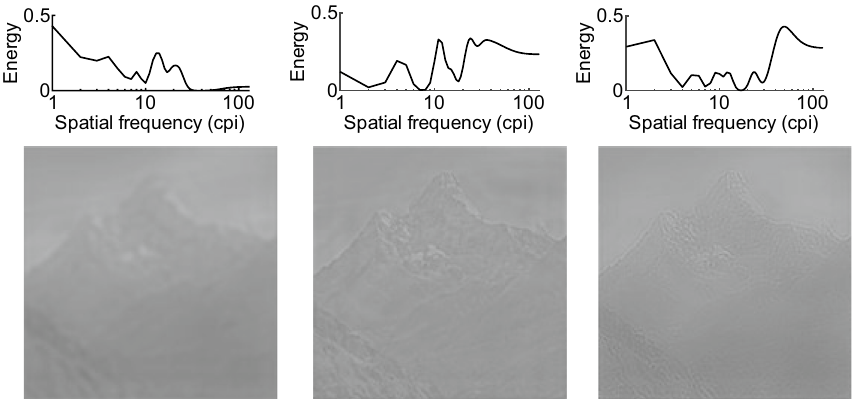
Figure 3. Random 1D SF filters and corresponding filtered stimuli. The filters (upper panel) are created with the SF Bubbles technique (see text for details). Each filter corresponds to one column of the matrix shown in Fig. 2f. The filtered stimuli (lower panel) contain only SF information passing through the corresponding random filters (for the unfiltered base stimulus see Fig. 1). Note : In the experiments, we presented short videos consisting of 40 different filtered versions of a stimulus (see Supplementary Videos for examples). cpi = cycles per